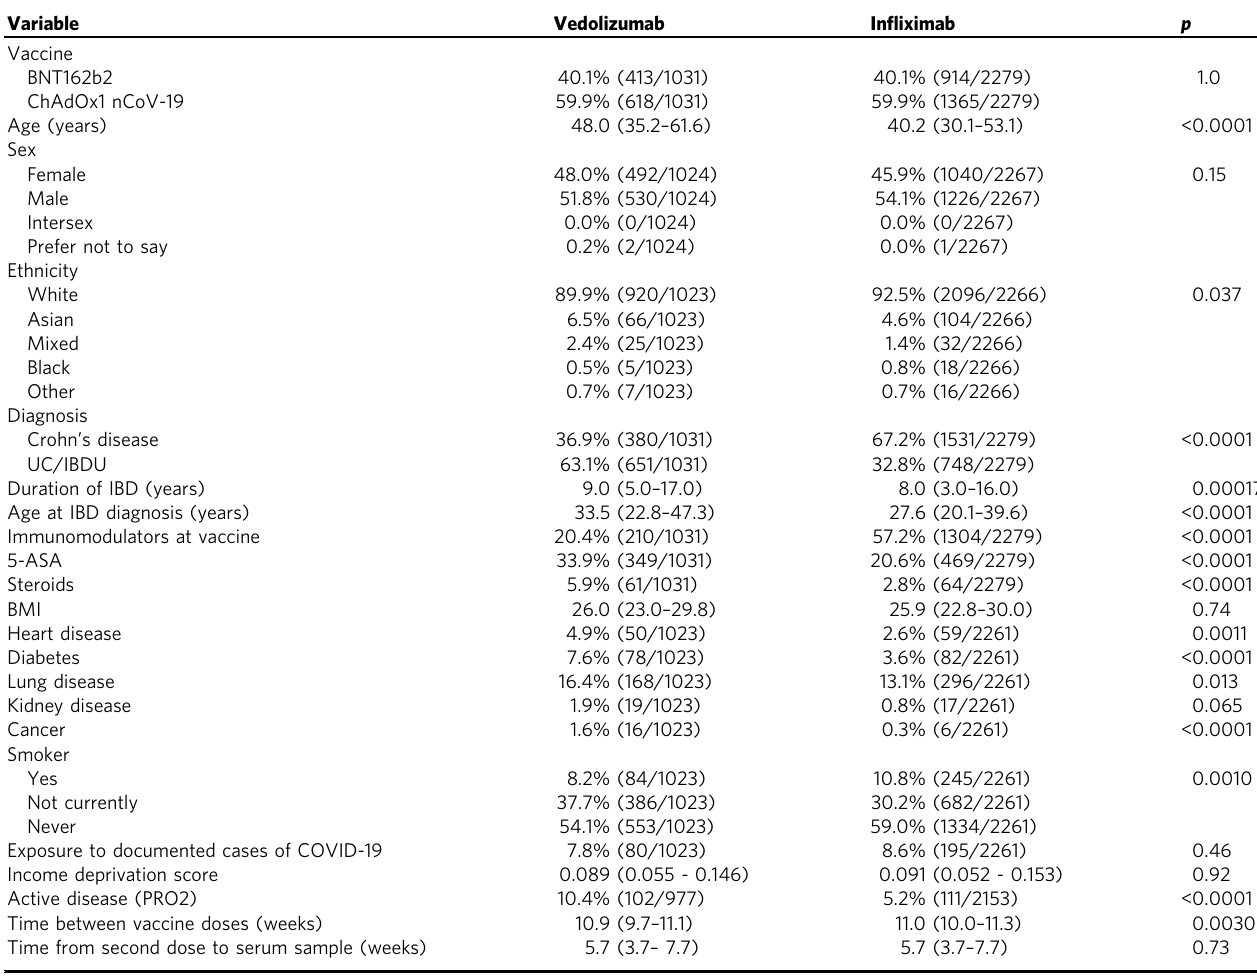
Table 1 Baseline characteristics of participants who had anti-S receptor-binding domain antibodies measured 2 to 10 weeks following two doses of SARS-CoV-2